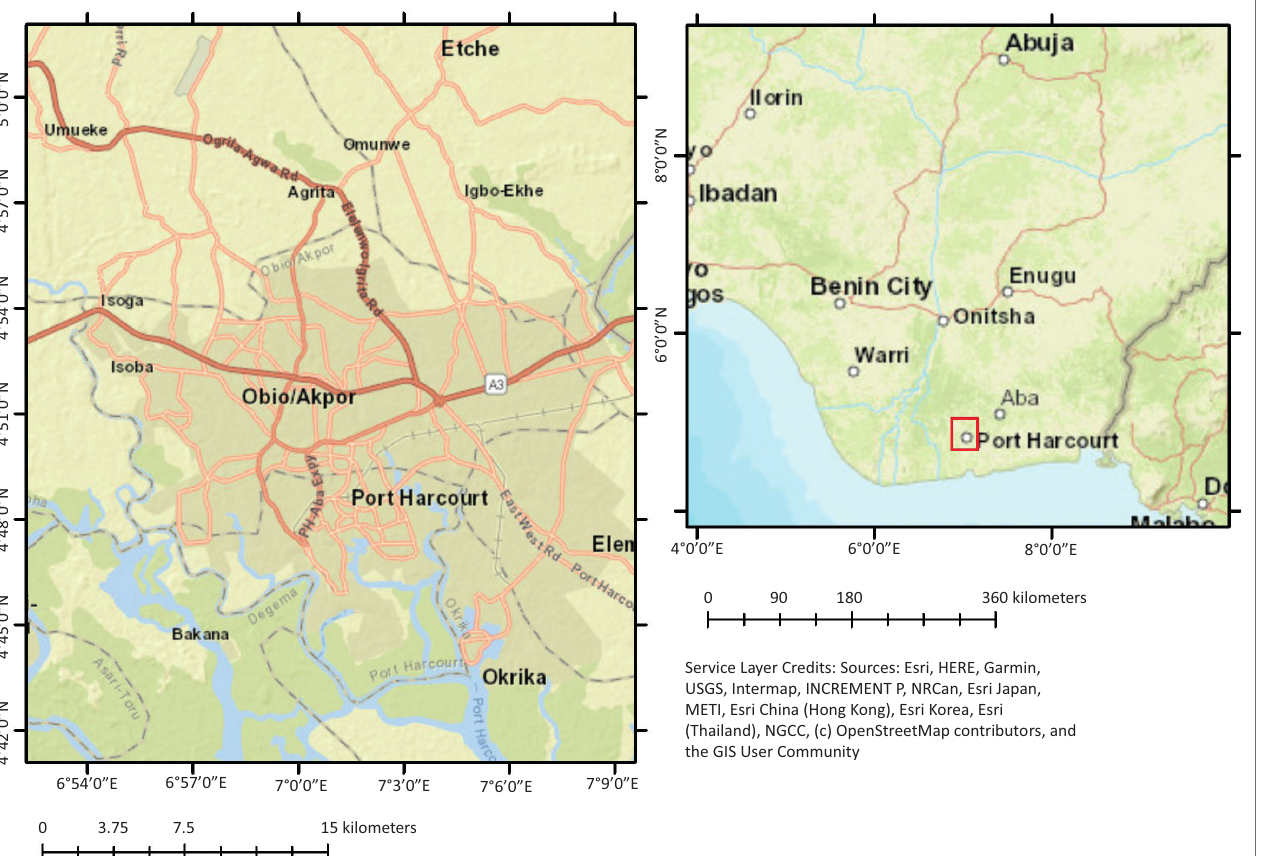
FIGURE 1: Obio-Akpor local government area and its